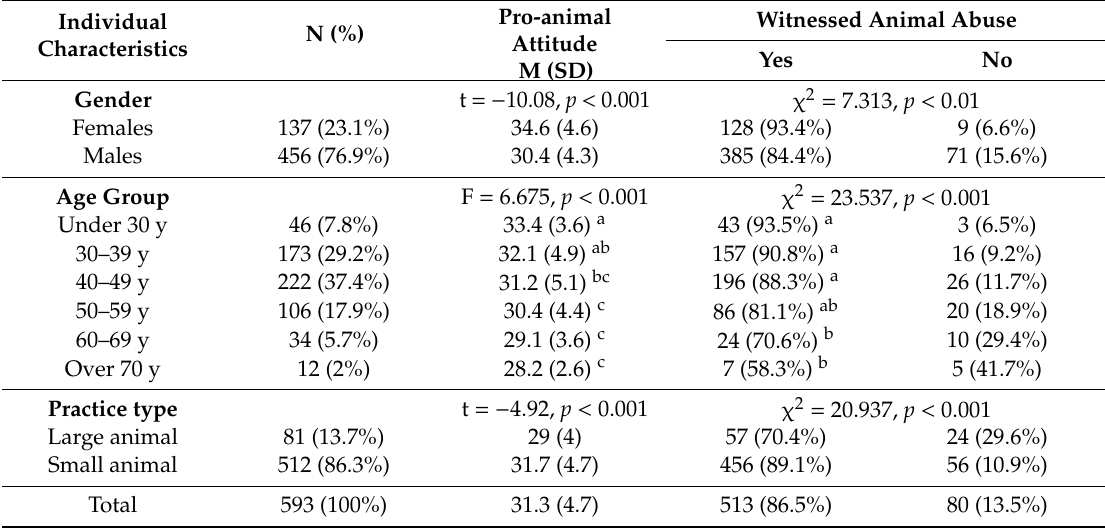
Table 1. Respondents’ individual characteristics and responses to witnessing animal